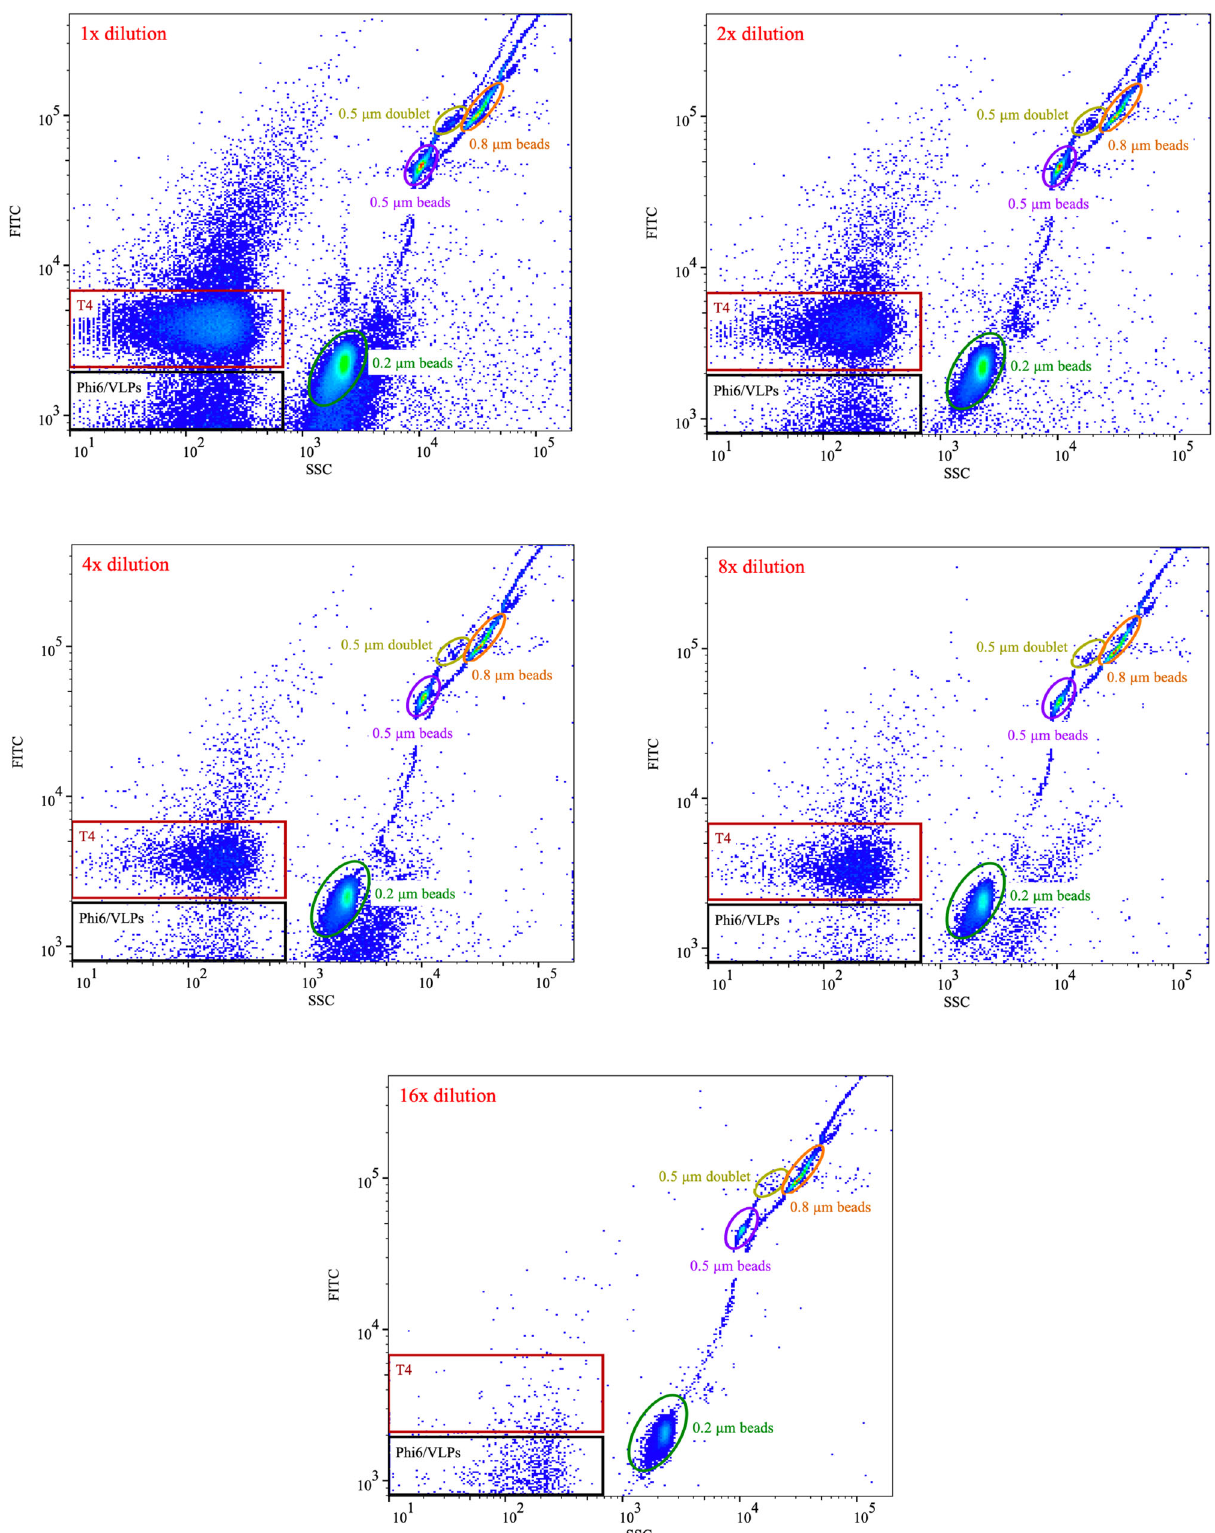
Fig. 3 Representative plots showing manual gating of data collected from mixed-target experiments. Gates were drawn based on the 1× dilution, then applied to data from all dilutions. Per the manufacturer ’ s technical documentation, the streaking pattern exhibited by the 0.5 and 0.8 μ m beads is a characteristic result. It is likely an artifact of variability in the bead-manufacturing